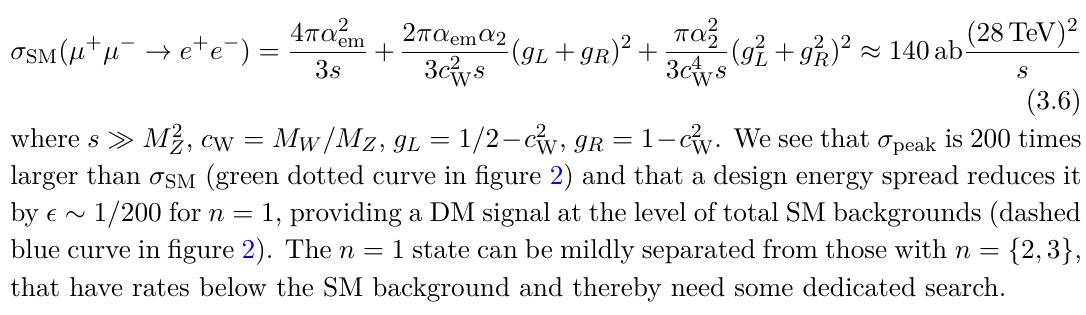
Figure 2. Bound-state signals of a Minimal Dark Matter 5-plet with constituent mass M = 14 TeV . The dotted green curves show the signal cross section for production of n s n = { 1 , 2 , 3 } , ignoring the beam energy spread. The dashed curves show the signal cross section, for two different values of the beam energy spread, σ (feasible value). The continuous curves show the signal cross section after also taking into account initial state emission. The gray horizontal curve is the SM µ + µ − → e + e −